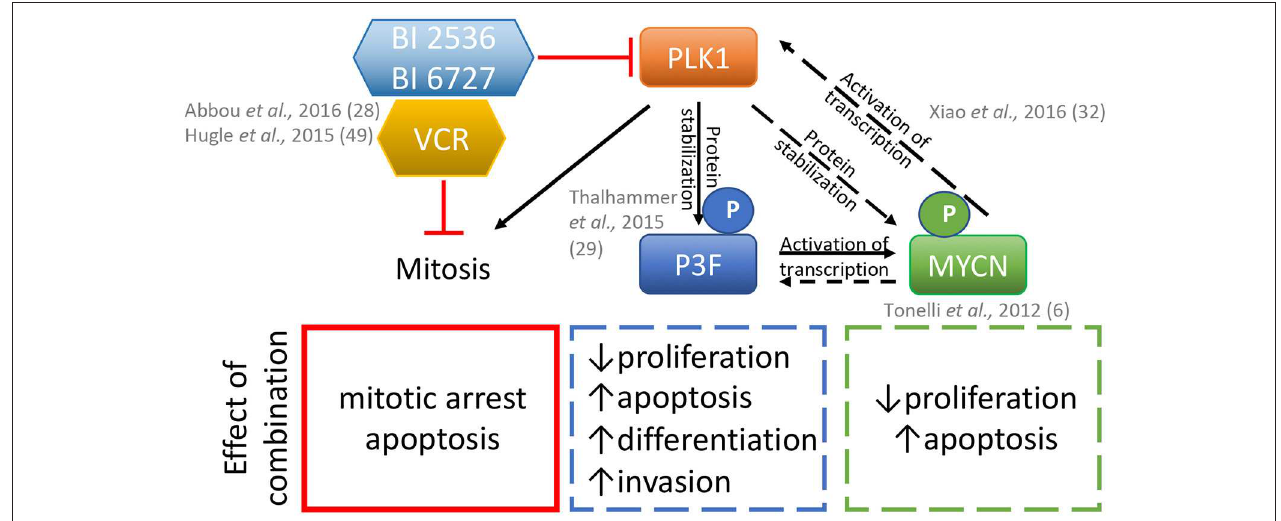
FIGURE 1 | Model for the effects of the combination of PLK1 inhibitors BI2536 or BI6727 (volasertib) plus the microtubule disrupter vincristine (VCR) on rhabdomyosarcoma cells. Inhibition of PLK1 and vincristine disrupts mitosis which in combination can synergistically lead to apoptosis. PLK1 inhibition also affects the phosphorylation of the PAX3-FOXO1 (P3F) protein and MYCN either indirectly via P3F loss and/or directly via its phosphorylation status, and may additionally contribute to the effects of these inhibitors in fusion positive rhabdomyosarcomas. Dashed and solid lines, represent proven and plausible links and effects in rhabdomyosarcoma models,